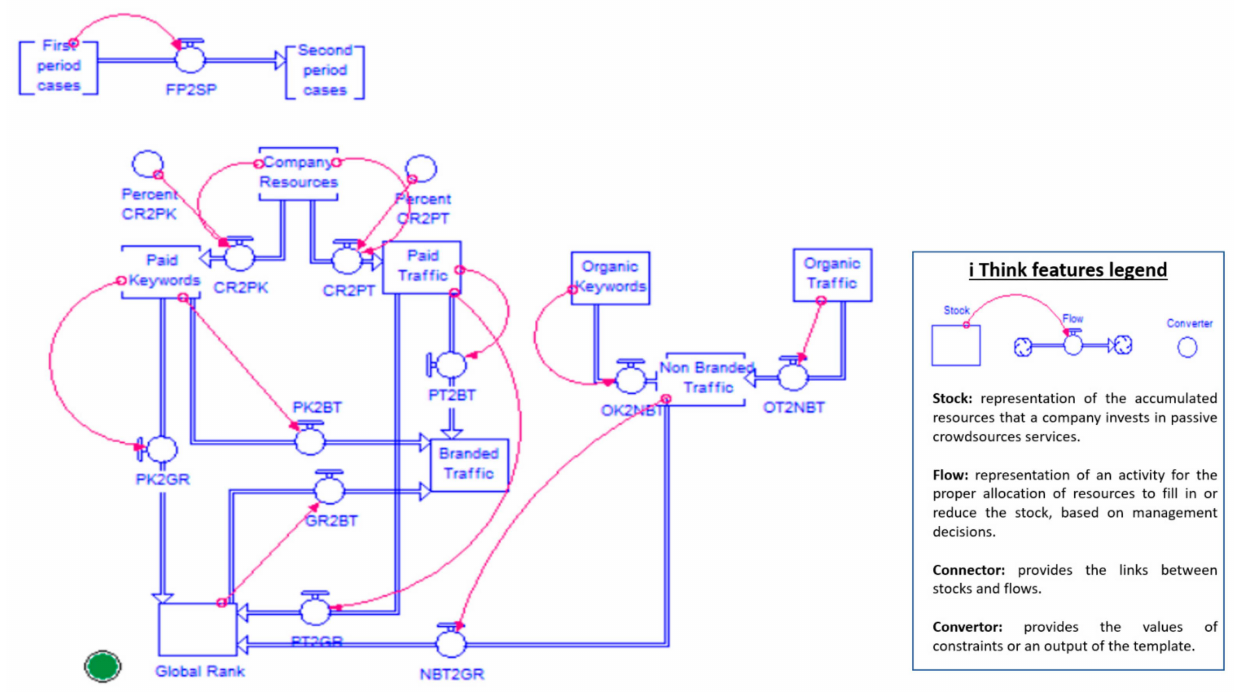
Figure 8. Dynamic simulation model